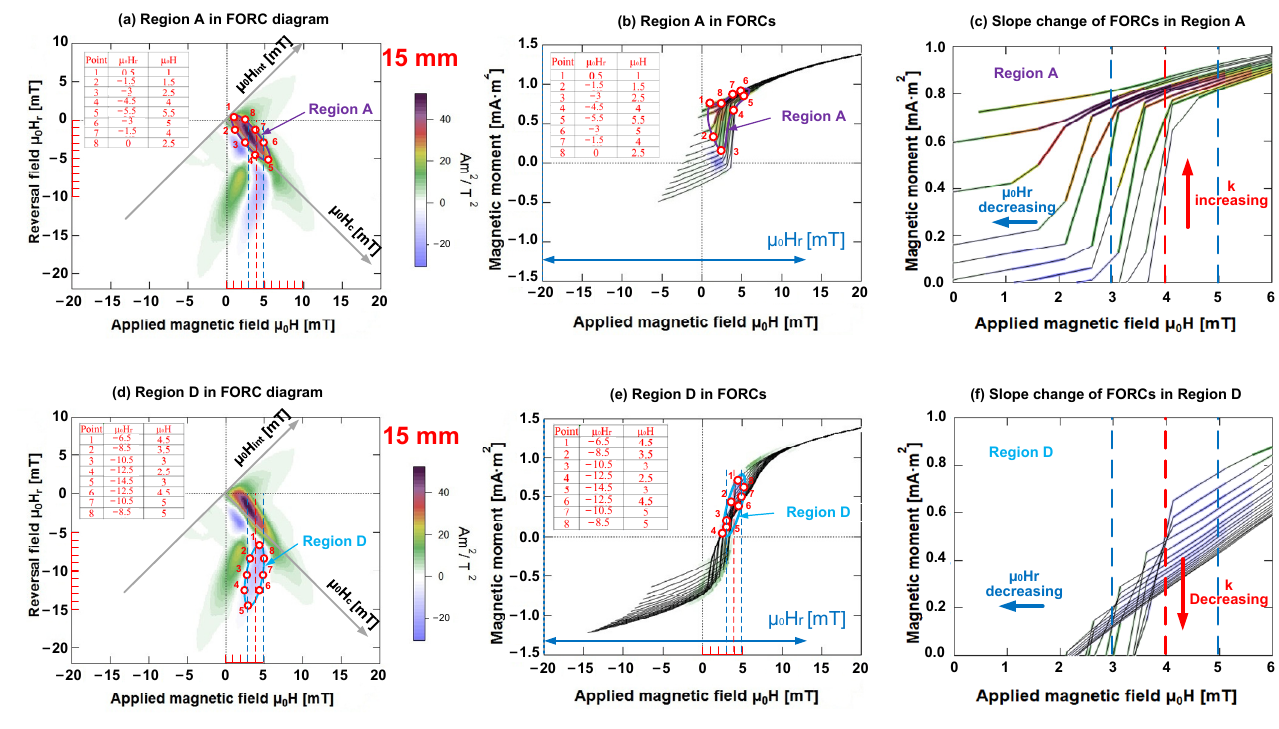
Figure 10. Comparison of positive and negative distributions in FORC diagram in same applied magnetic field. ( a ) Region A in FORC diagram; ( b ) Region A in several FORCs; ( c ) slope change of FORCs in region A; ( d ) Region D in FORC diagram; ( e ) Region D in several FORCs; ( f ) slope change of FORCs in region D.